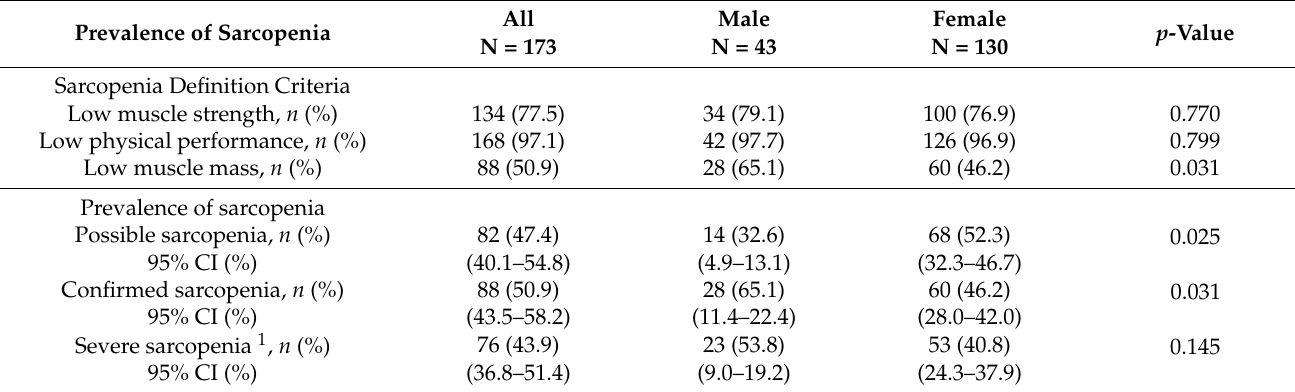
Table 2. Prevalence of sarcopenia, stratified by gender ( n = 173).